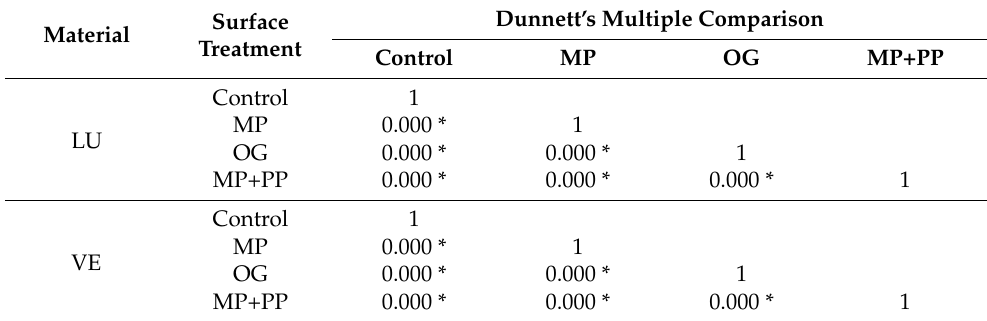
Table 7. Pairwise comparison of the GU of the surface-treated CAD/CAM